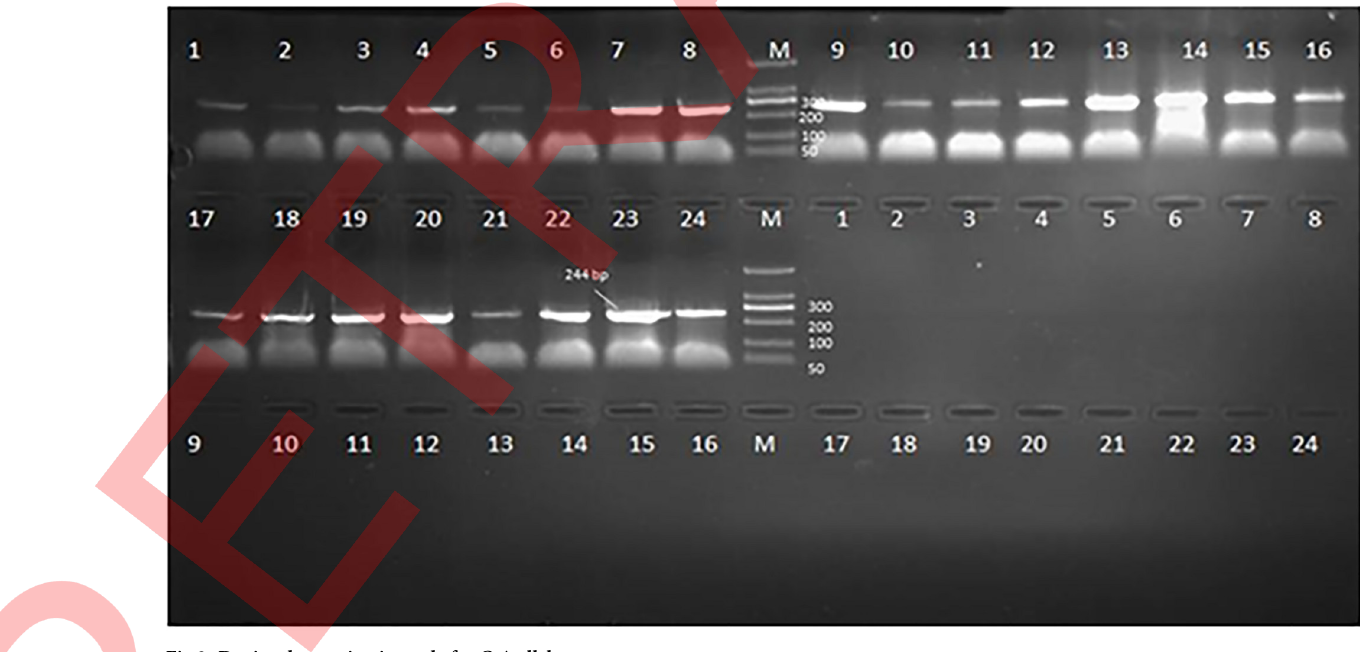
Fig 2. Depicted accession in study for C-A